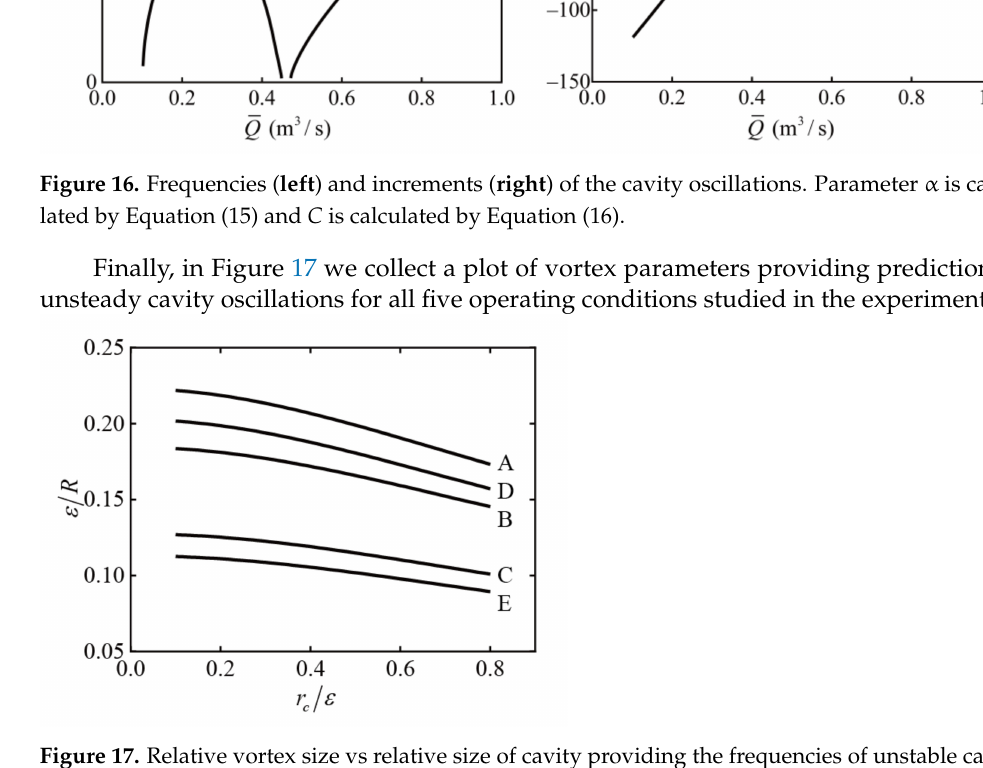
Figure 17. Relative vortex size vs relative size of cavity providing the frequencies of unstable cavity oscillations found in the current experiments. The characters A–E correspond to the experimental operating conditions of PT (see Figure